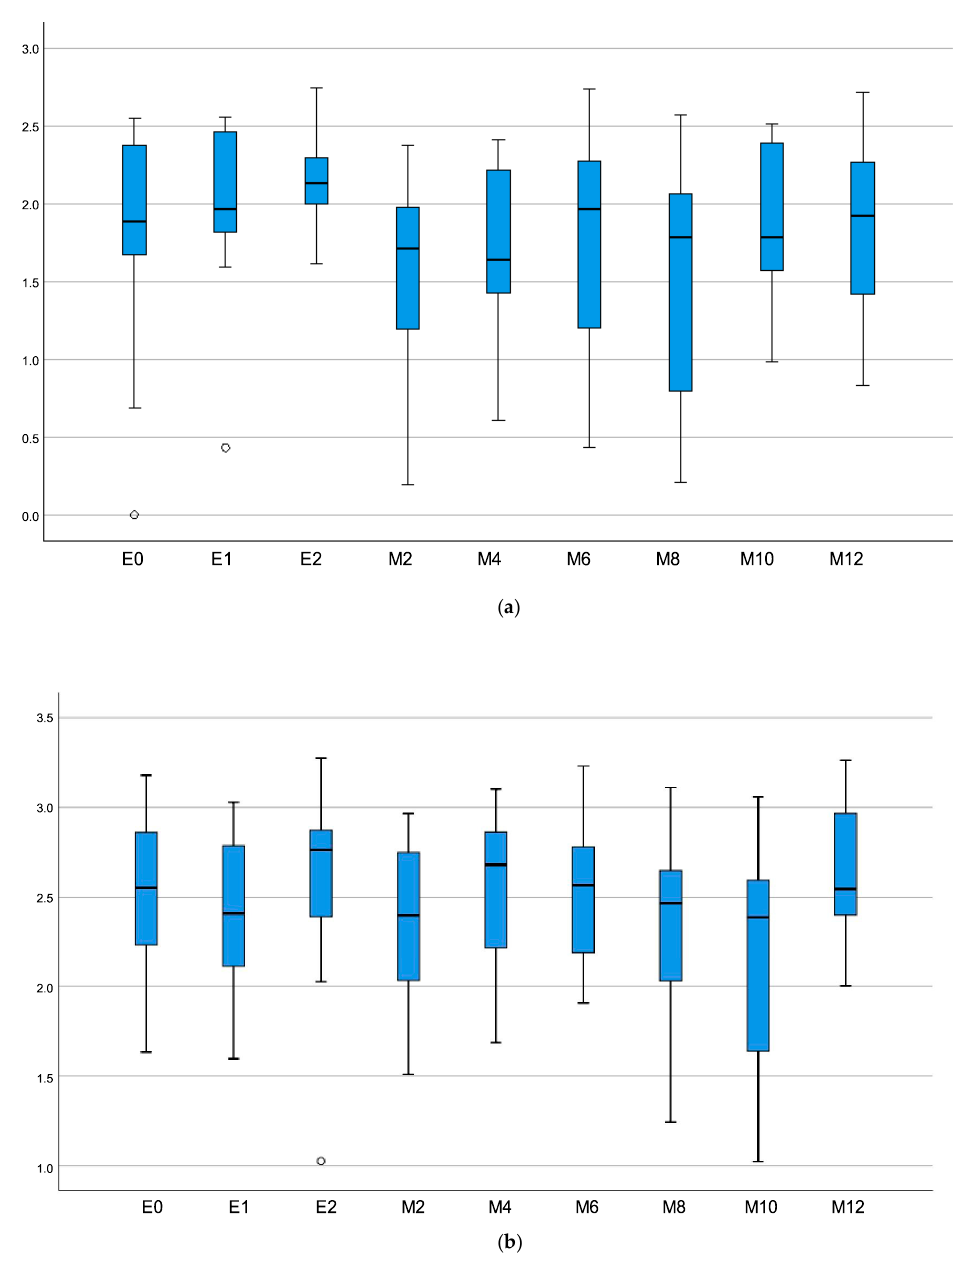
Figure 1. Shannon diversity index for each sample time for ( a ) HhaI -digestion and ( b ) MspI -digestion. There was no difference in microbiota diversity in CD patients at the diagnosis and while on EEN (second and last day of EEN and during follow-up).